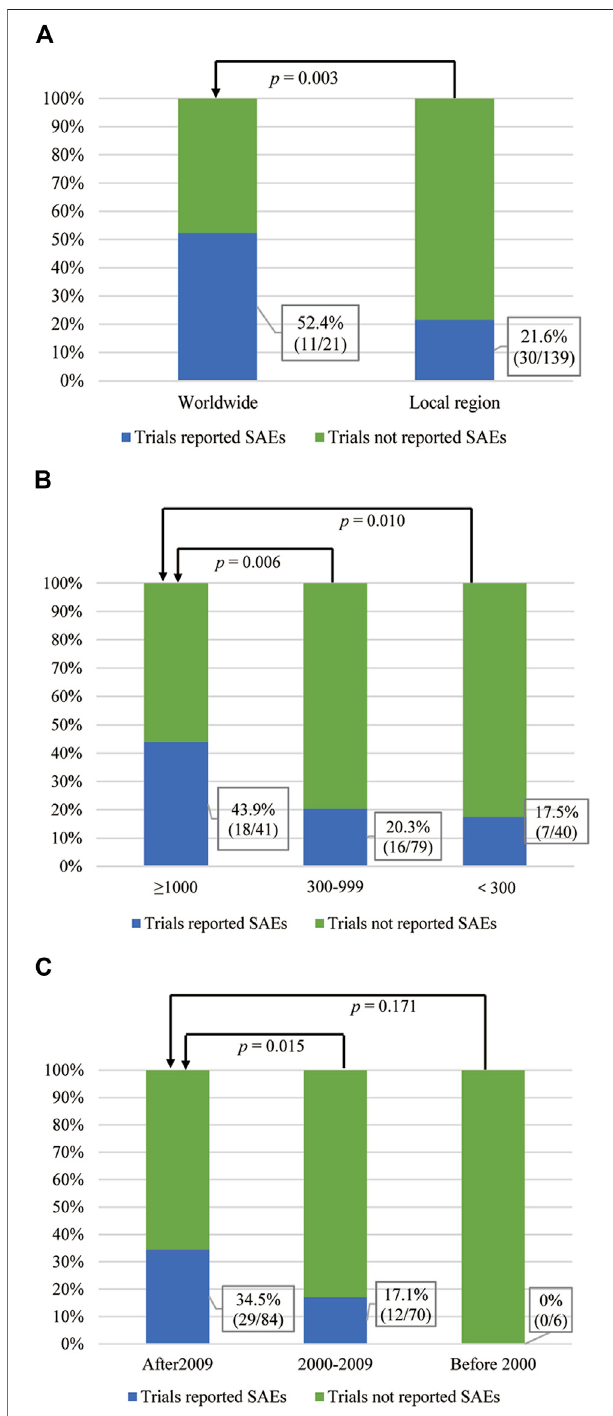
FIGURE 3 | The correlation between the RP of SAEs and the in fl uencing factors. (A) Region where clinical trials conducted and SAEs reported status. (B) Sample size and SAE reported status. (C) Publication time and SAEs reported status.